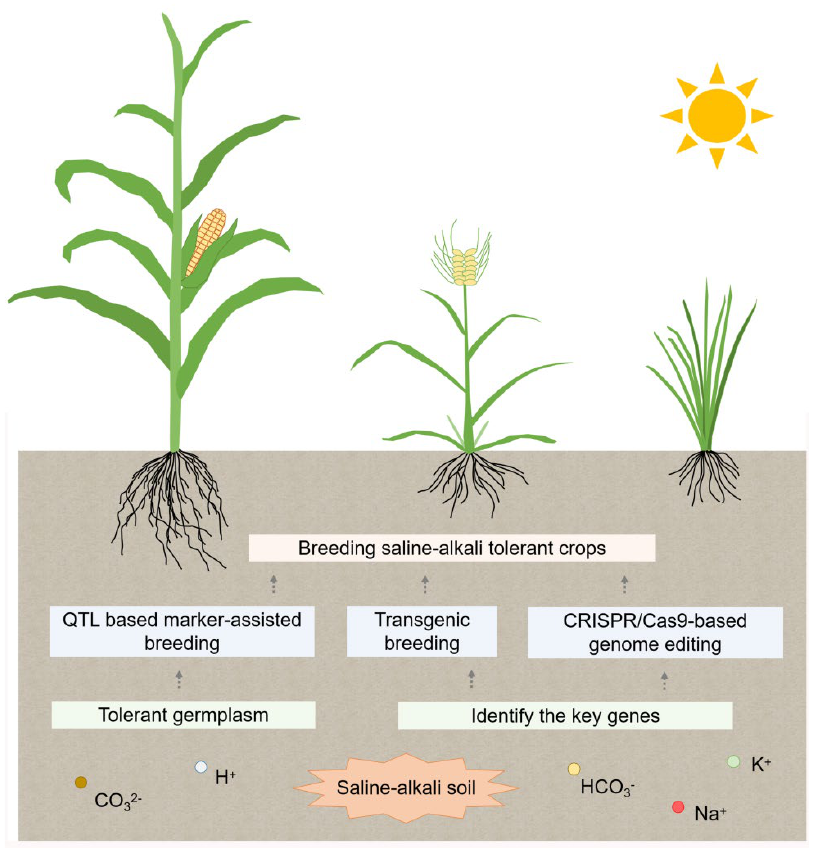
Figure 4. Schematic diagram of developing saline-alkali tolerant crops based on modern breeding. Screening the saline-alkali tolerant germplasm, and identifying key determinants that regulate plants saline-alkali tolerance based on QTL, GWAS analysis, etc. Then introgression/transfer favorable alleles into elite varieties to develop saline-alkali tolerant crops by modern breeding approach, which include QTL based marker-assisted breeding (MAS), transgenic breeding and CRISPR/Cas9-based genome editing